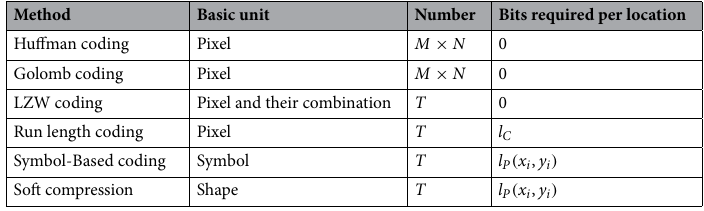
Table 1. Some image compression methods.